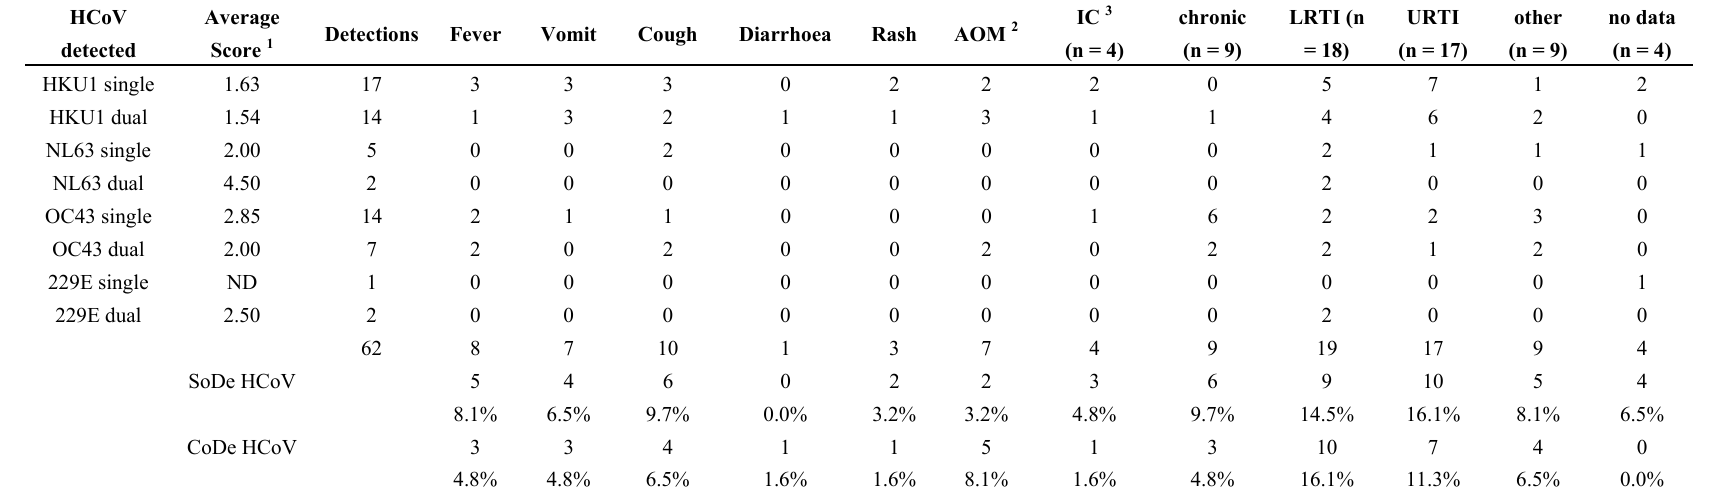
Table 3. Clinical features of patients positive for an